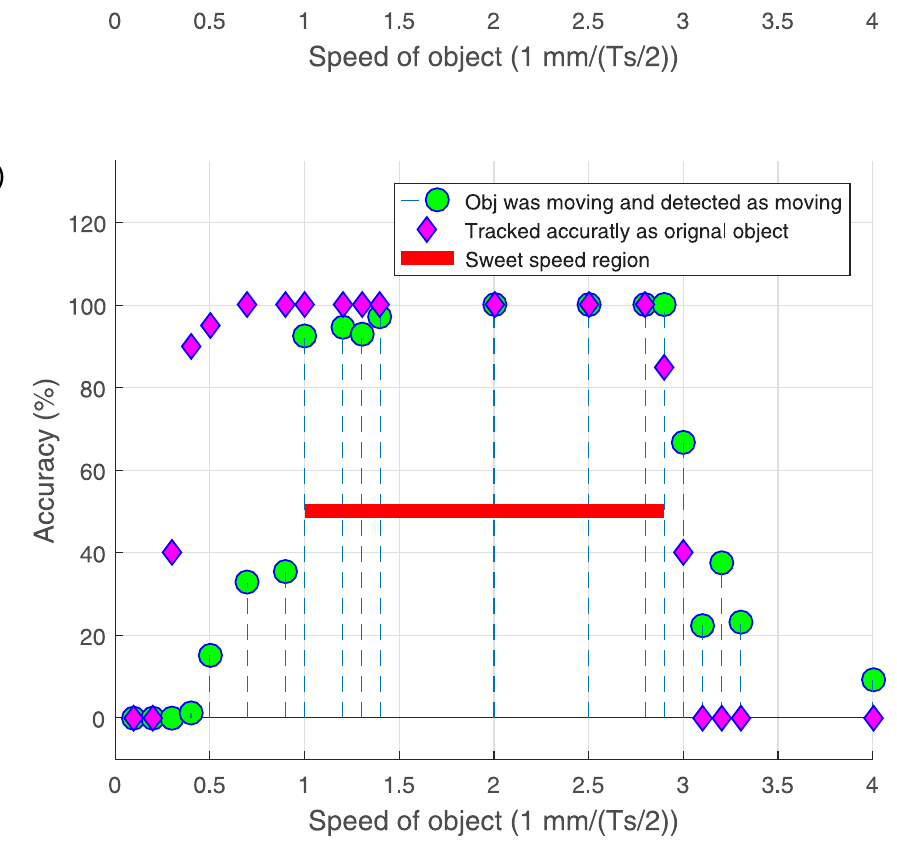
Fig 9. Boundaries of the